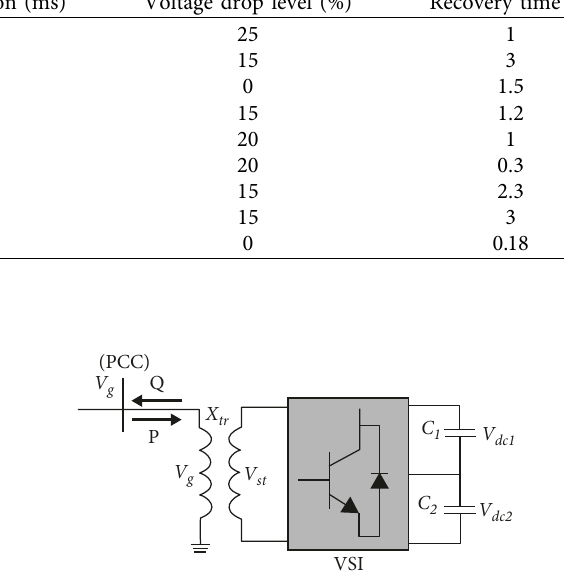
Figure 4: Equivalent circuit of the STATCOM [33].